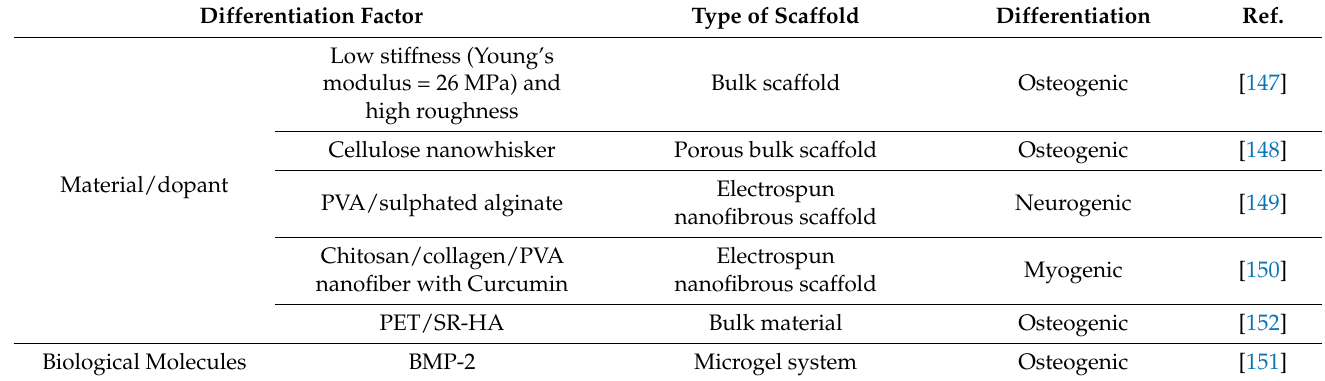
Table 4. Influence of other polymeric biomaterials on cell